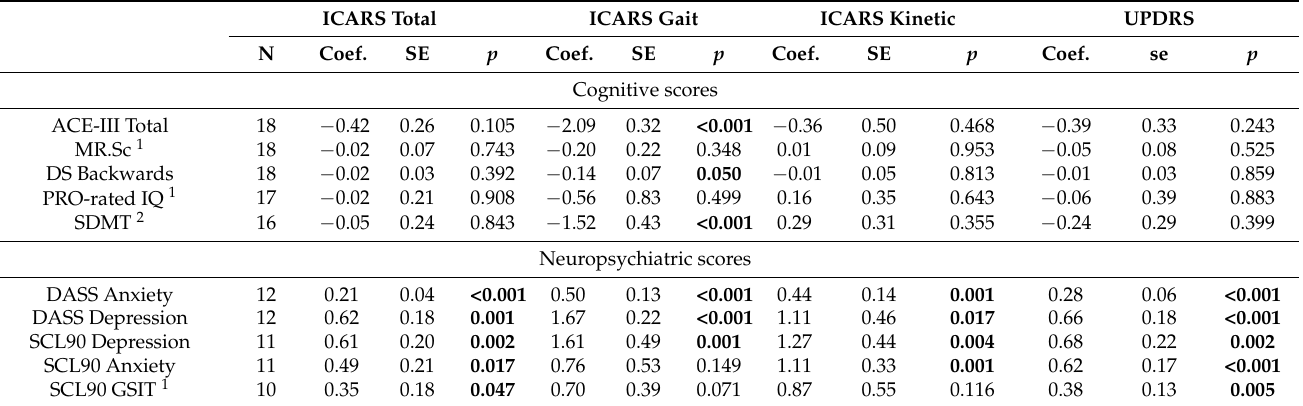
Table 3. Relationship between each cognitive or neuropsychiatric (outcome) and motor (predictor) score for the FXTAS group. ICARS Total